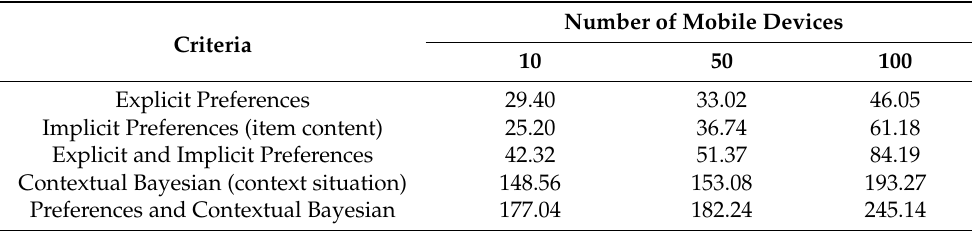
Table 8. Evaluation of response time (ms) of proposed approach using different criteria (number of situation rules is fixed to